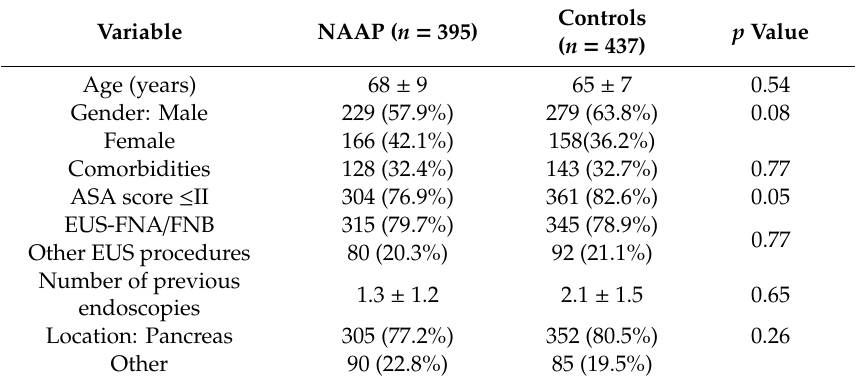
Table 1. Baseline patients’ characteristics before propensity score